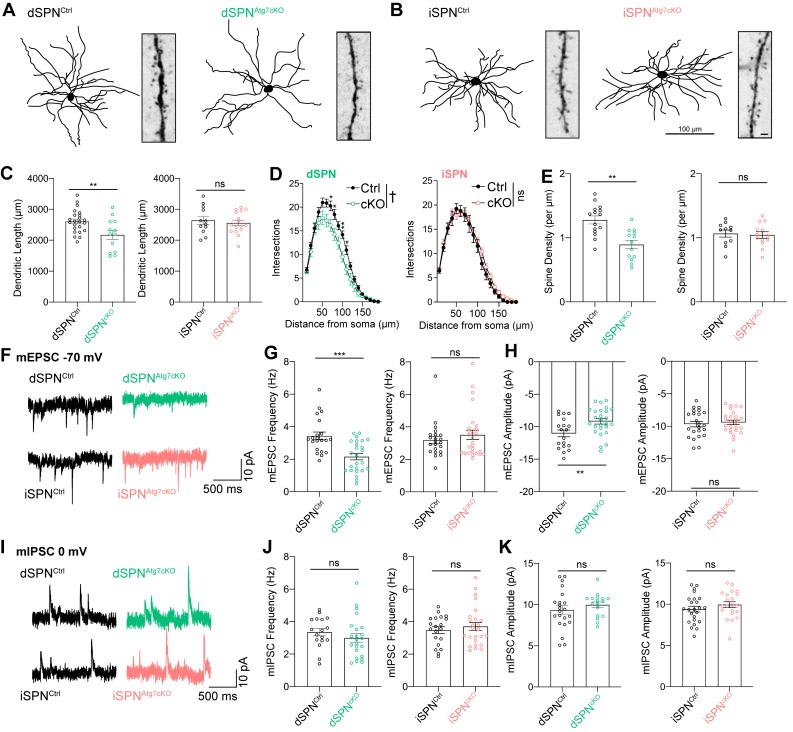
Atg7 contributes to synaptic function and dendritic complexity in dSPNs but not iSPNs.(A) Sample dendritic trees of dSPNs from control of dSPNAtg7cKO mice. Reconstructions of neurobiotin filled neurons (left) and dendritic segment (right). (B) Sample dendritic trees from reconstructed iSPNs in control or iSPNAtg7cKO mice. Left: reconstructed dendritic tree, scale bar 100 μm. Right: dendritic segment, scale bar 1 μm. (C) Cumulative dendritic length is significantly reduced in dSPNs from dSPNAtg7cKO mice compared to control (left) but not in iSPNs from iSPNAtg7cKO mice compared to control (right). dSPNCtrl: n = 22 cells, five mice, dSPNcKO: n = 12,4. iSPNCtrl: n = 12,3; iSPNcKO: n = 16,3. (D) Sholl analysis reveals a significant reduction in dendritic complexity in dSPNs from dSPNAtg7cKO mice compared to control (left) but not in iSPNs from iSPNAtg7cKO mice compared to control (right). dSPNCtrl: n = 22, 5, dSPNcKO: n = 12,4. iSPNCtrl: n = 13,3; iSPNcKO: n = 16,3. (E) Dendritic spine density on dendritic segments 50–100 µm from the soma. dSPNCtrl: n = 15, 5, dSPNcKO: n = 13,4. iSPNCtrl: n = 8,3; iSPNcKO: n = 8,3. (F) Representative traces of mEPSCs in dSPNs (top) and iSPNs (bottom). (G-H) A significant reduction in (G) mEPSC frequency and (H) mEPSC amplitude in dSPNs from dSPNAtg7cKO mice compared to control but no difference in iSPN mEPSC frequency or amplitude between genotypes. Frequency: dSPNCtrl: n = 21, 5, dSPNcKO: n = 25,4. iSPNCtrl: n = 22,3; iSPNcKO: n = 26,4. Amplitude: dSPNCtrl: n = 19, 5, dSPNcKO: n = 26,4. iSPNCtrl: n = 23,5; iSPNcKO: n = 26,4. (I) Representative traces of mIPSCs in dSPNs (top) and iSPNs (bottom) (J-K) No difference in mIPSC frequency or amplitude after loss of autophagy in either dSPNs or iSPNs. Frequency: dSPNCtrl: n = 17, 5, dSPNcKO: n = 23,4. iSPNCtrl: n = 20,5; iSPNcKO: n = 25,4. Amplitude: dSPNCtrl: n = 17,5, dSPNcKO: n = 22,4. iSPNCtrl: n = 21,5; iSPNcKO: n = 24,4. See Table 2 for detailed statistics. ns p>0.05, *p<0.05, **p<0.01, † p<0.0001.